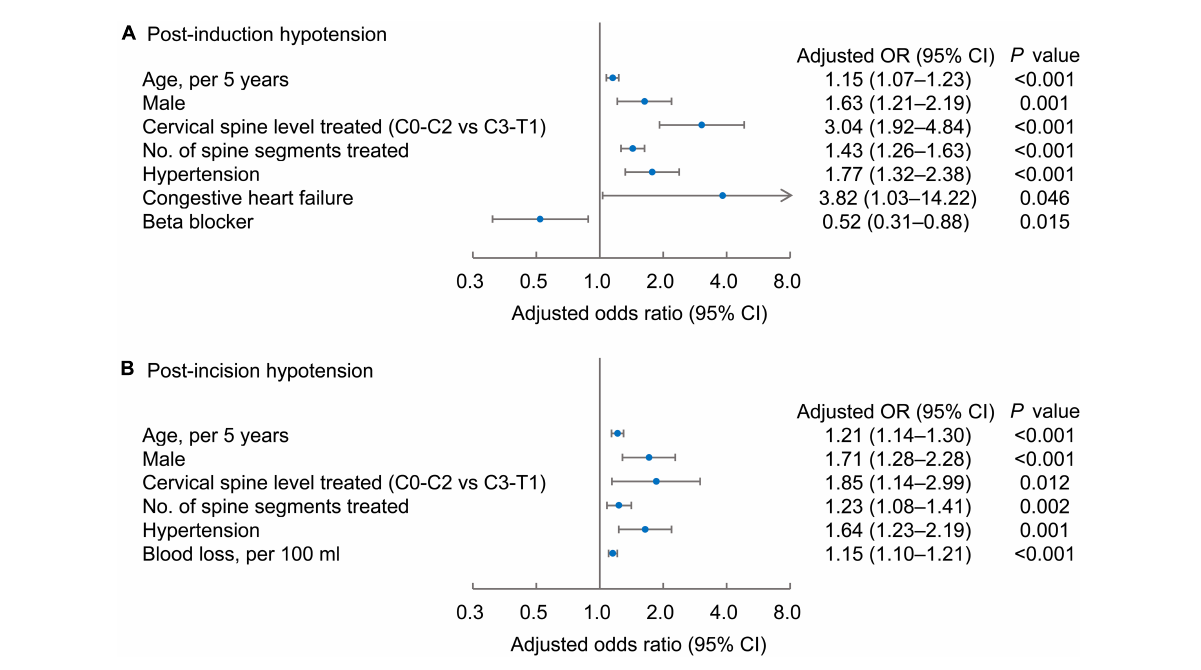
FIGURE2 Risk factors independently associated with post-induction (A) and post-incision hypotension (B) . Forest plots of the adjusted odd ratios (dots) with 95% confidence intervals (95% CI; whiskers) of the multivariable regression models, with post-induction or post-incision hypotension as the dependent variable.